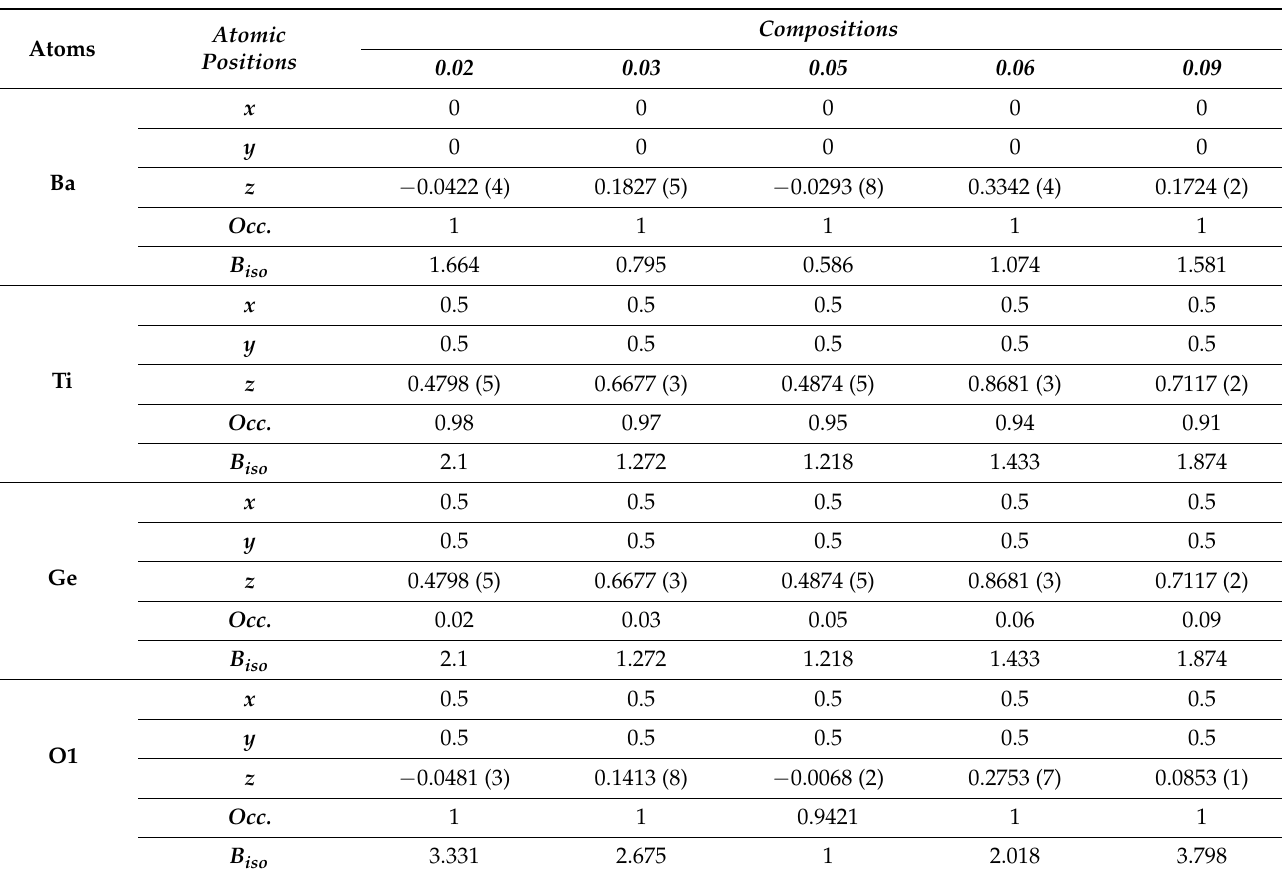
Table 1. Atomic positions and Rietveld reliability factors for BTGx (x = 0.02, 0.03, 0.05, 0.06, 0.09)